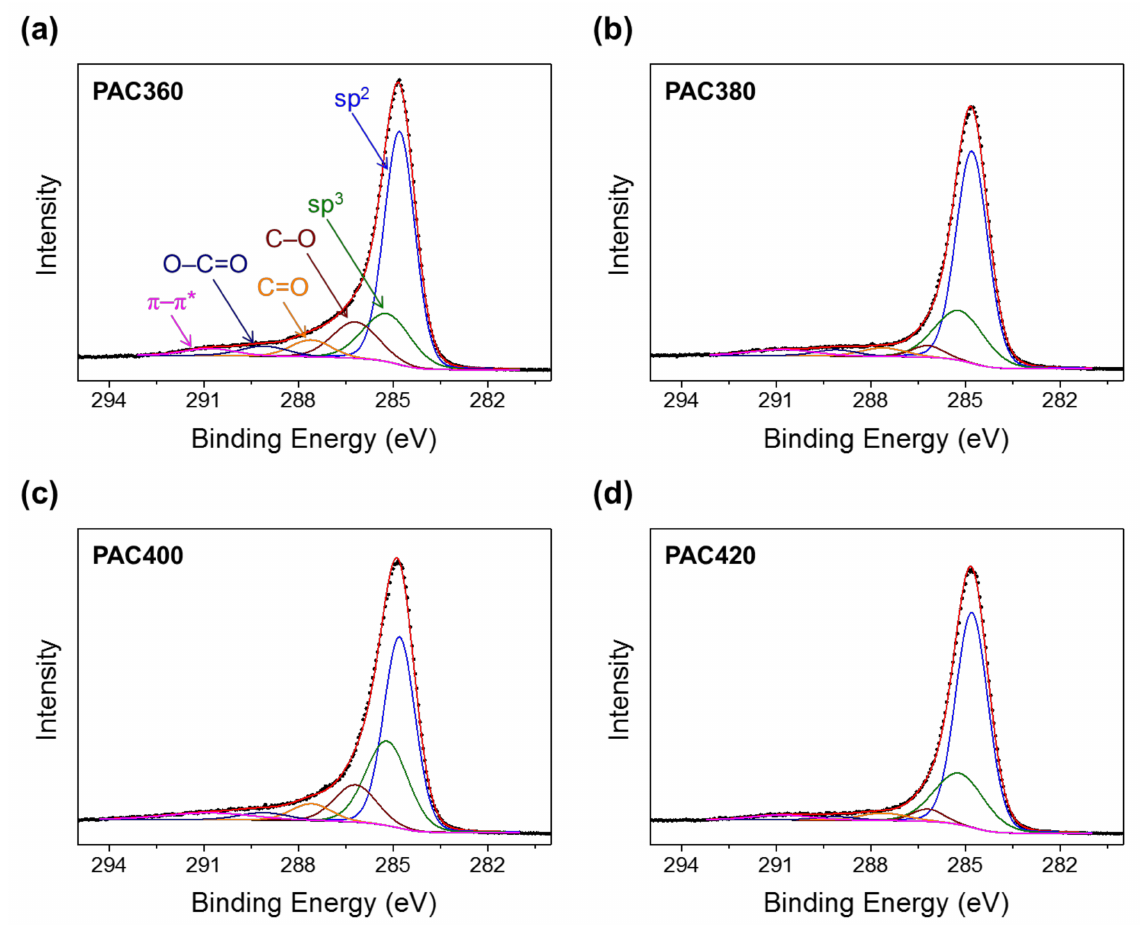
Figure 6. XPS C 1s spectra of ( a ) PAC360, ( b ) PAC380, ( c ) PAC400, and ( d )